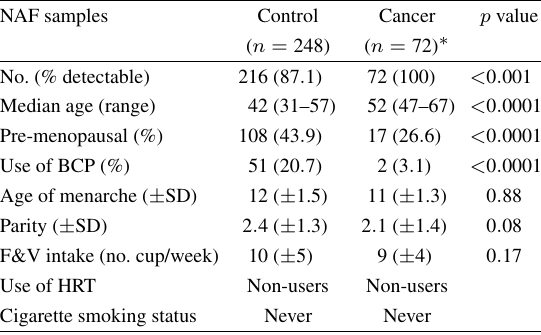
Demographic data for women analyzed in the present study ( n = 320) NAF